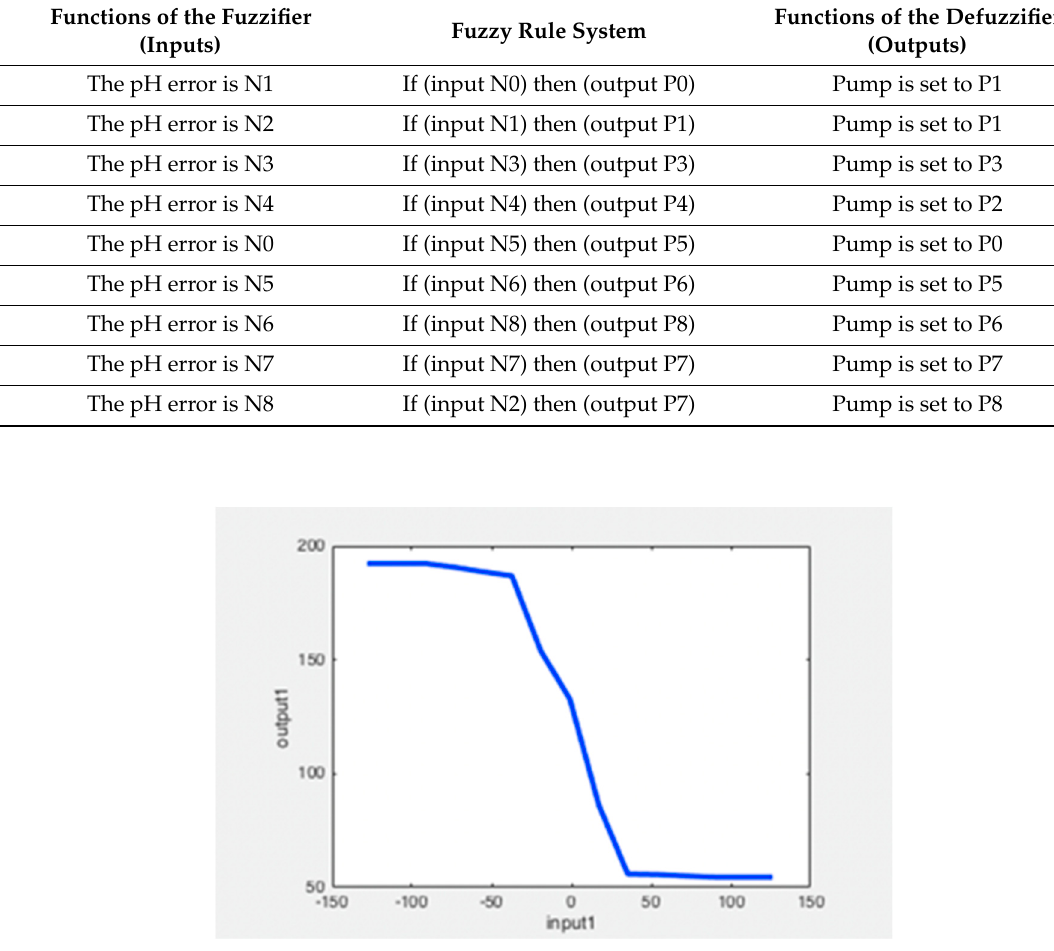
Figure A5. Fuzzy system response curve.